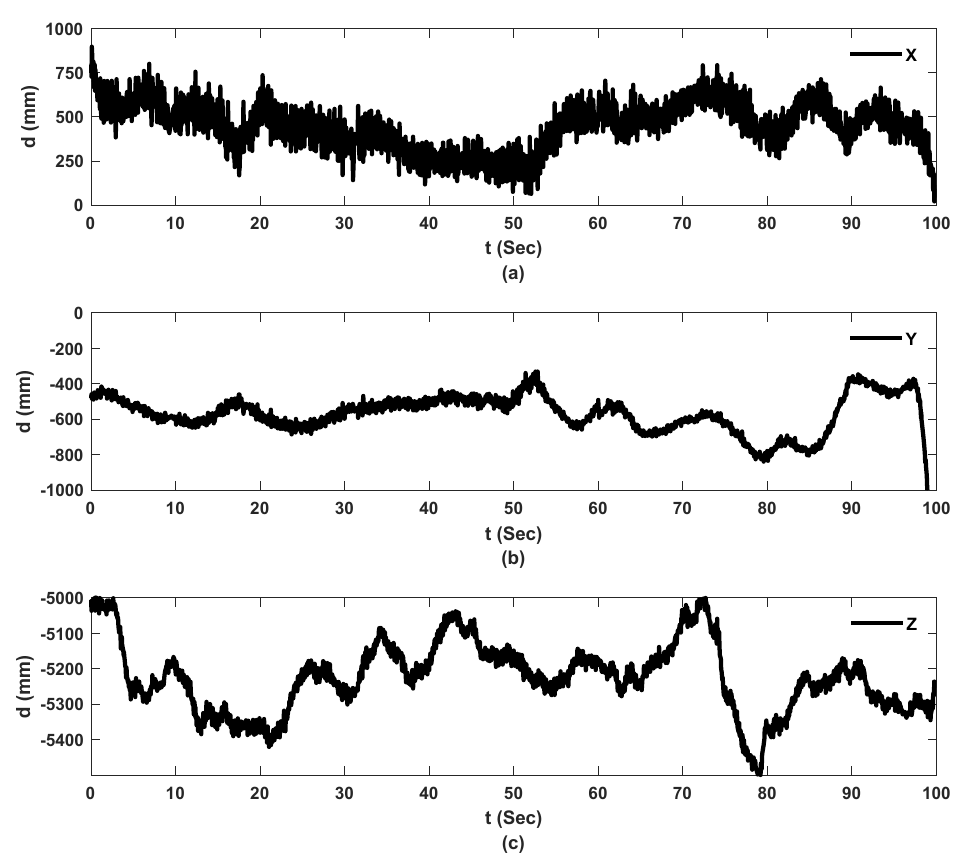
Figure 9. Translational motion of the UAS tracked by camera, experiment 2: ( a ) X direction of the camera; ( b ) Y direction of the camera corresponds to direction of interest (toward bridge); ( c ) Z direction of the camera.